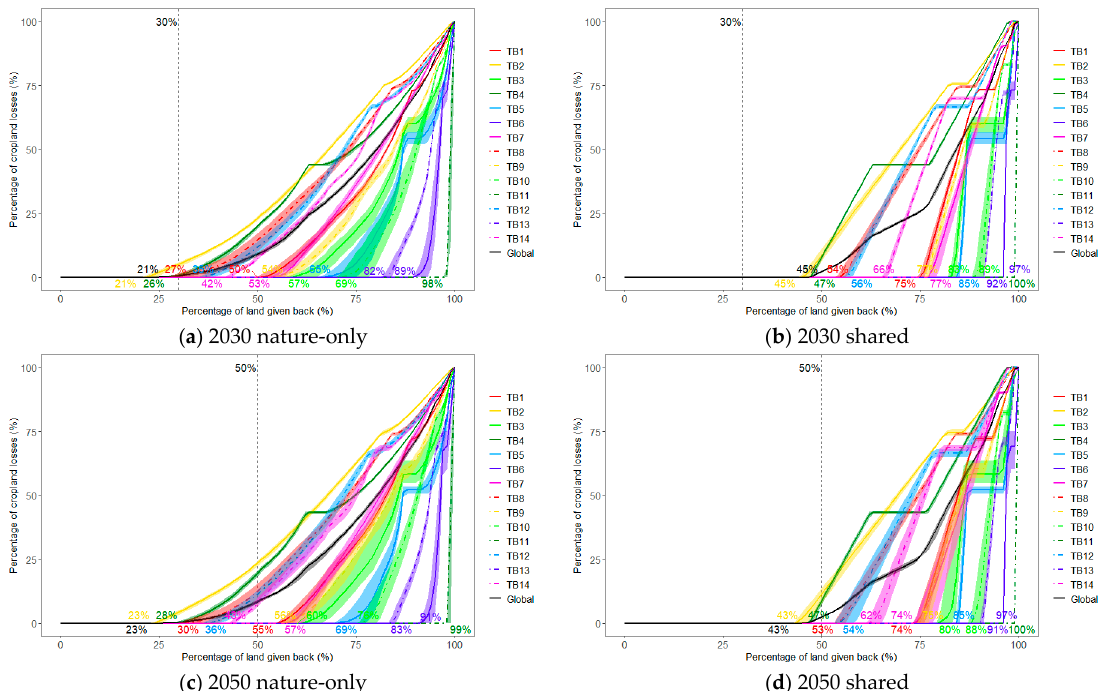
Figure 7. Cropland losses of all TBs and the globe at the biome scale. The figure shows the percentages of cropland abandoned within each TB and the whole globe as the terrestrial area given back to nature increasing. The curve reflects the mean value of all 8 scenarios and the shadows show ranges of all scenarios. The specific percentage of land given bank at which cropland begins to be abandoned is marked. Land given back and cropland losses are both shown in